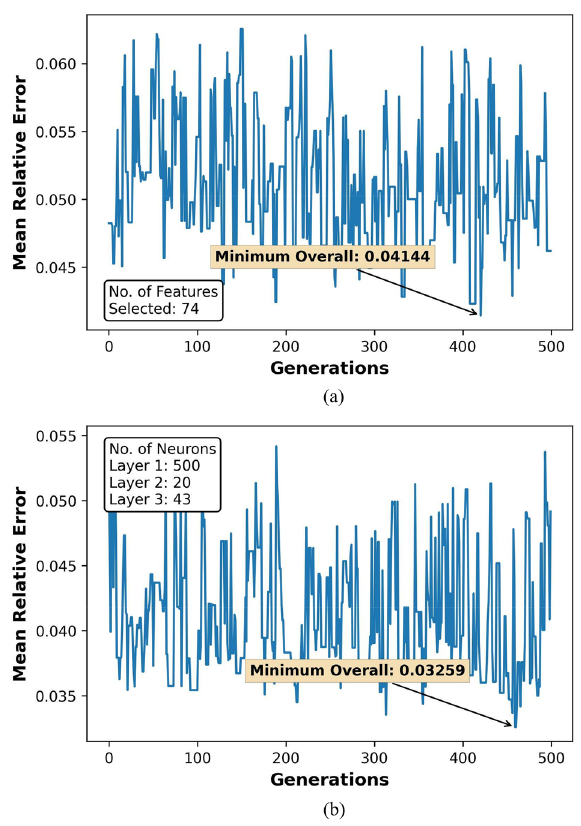
Figure 10. MRE for regressor ANN model during ( a ) feature selection and ( b ) hyperparameter tuning for HO-CP